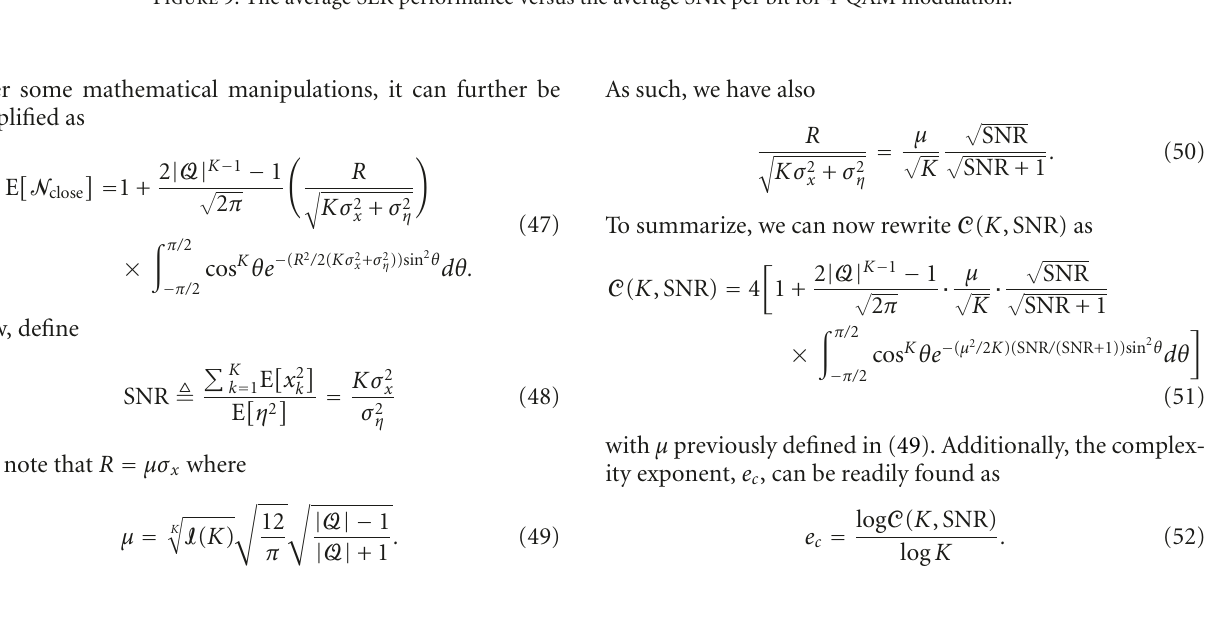
Figure 9: The average SER performance versus the average SNR per bit for 4-QAM